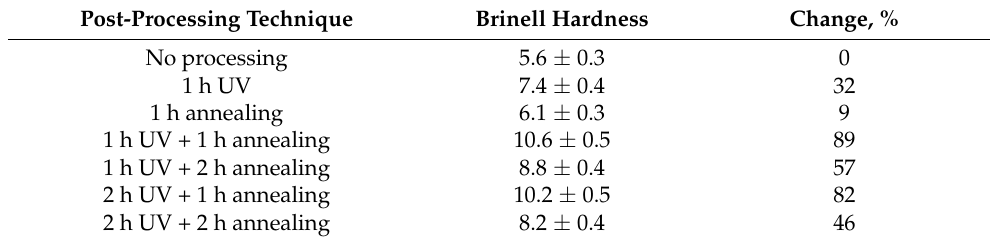
Table 1. Dependence of Brinell hardness on post-processing techniques and their duration. Post-Processing Technique